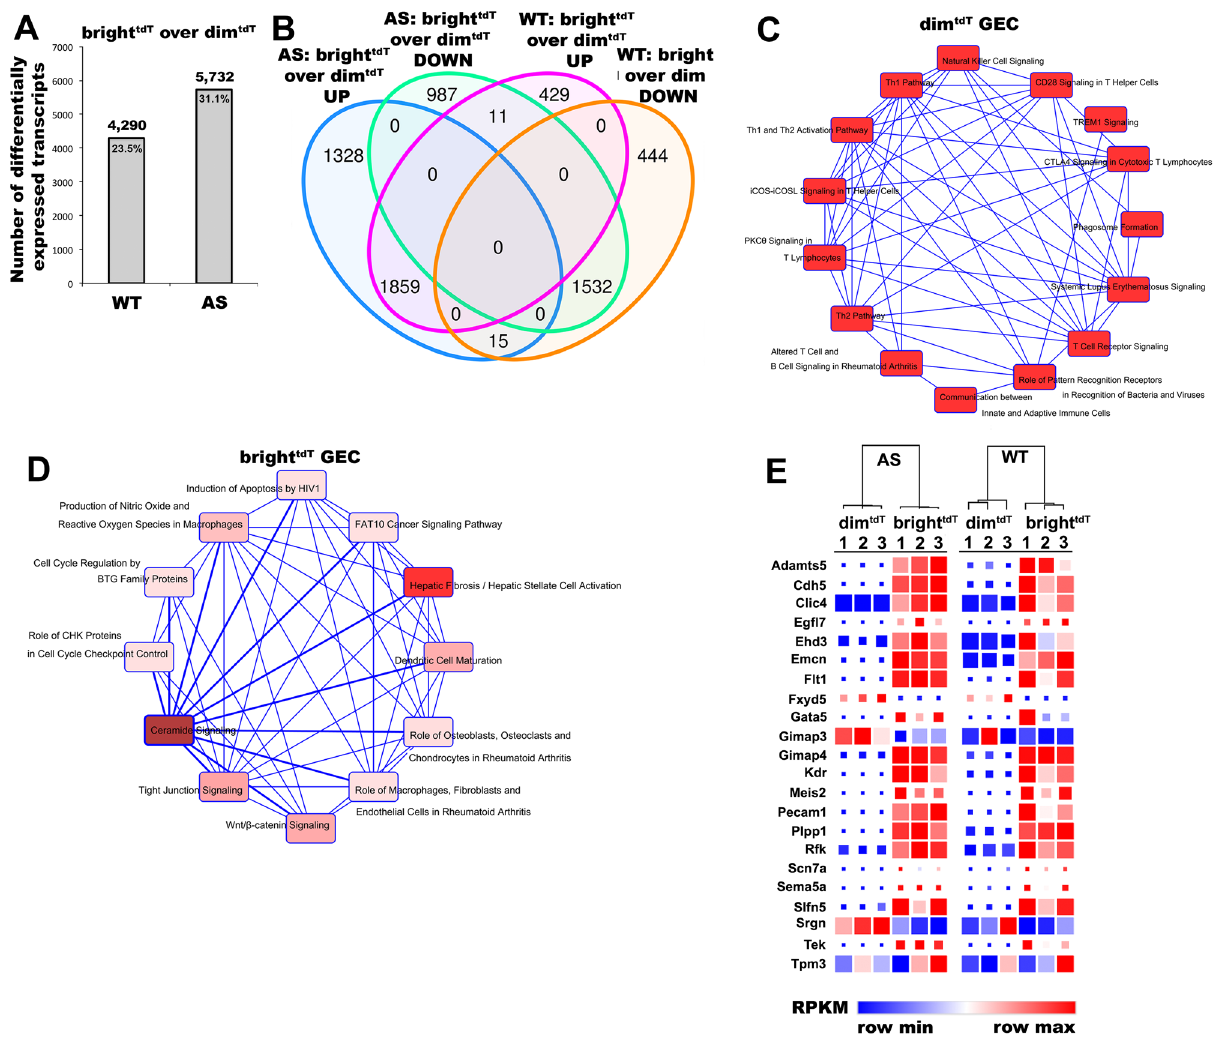
Figure 4. Transcriptome-wide comparison of GEC subpopulations. ( A) Bar graphs showing the number of genes with differential expression and associated percentages in bright tdT GEC compared to dim tdT GEC in both WT and AS mice. ( B) Venn diagram comparison of gene expression in bright tdT cells relative to dim tdT cells in WT and AS mice. Each of the four circles represents a set of genes differentially expressed between the two subpopulations; (blue and purple circles denote genes upregulated in bright tdT over dim tdT ; green and orange circles denote genes downregulated in bright tdT over dim tdT ). Numbers depicted in the intersections between circles represent the numbers of genes that are commonly up or down regulated in those groups. ( C, D) Network graphs showing the canonical molecular pathways defining the 308 transcripts solely expressed in the dim tdT cells ( C ), and the 33 transcripts solely expressed in the bright tdT cells ( D ) based on the IPA software analysis (Qiagen); color scale – red color intensity indicates stronger expression. ( E ) Heatmap diagrams with color-coded representation of the RPKM values comparing the transcriptional expression of endothelial specific genes between the bright tdT and dim tdT GEC in WT and between bright tdT and dim tdT AS mice. A comparison between WT and AS is presented in Fig. 8F. The color scale represents relative gene expression levels across each row with red denoting upregulation and blue denoting downregulation. Color intensity indicates stronger regulation. P value < 0.05 was applied as a cut-off point for all transcriptomic data analysis (biological replicates, n =